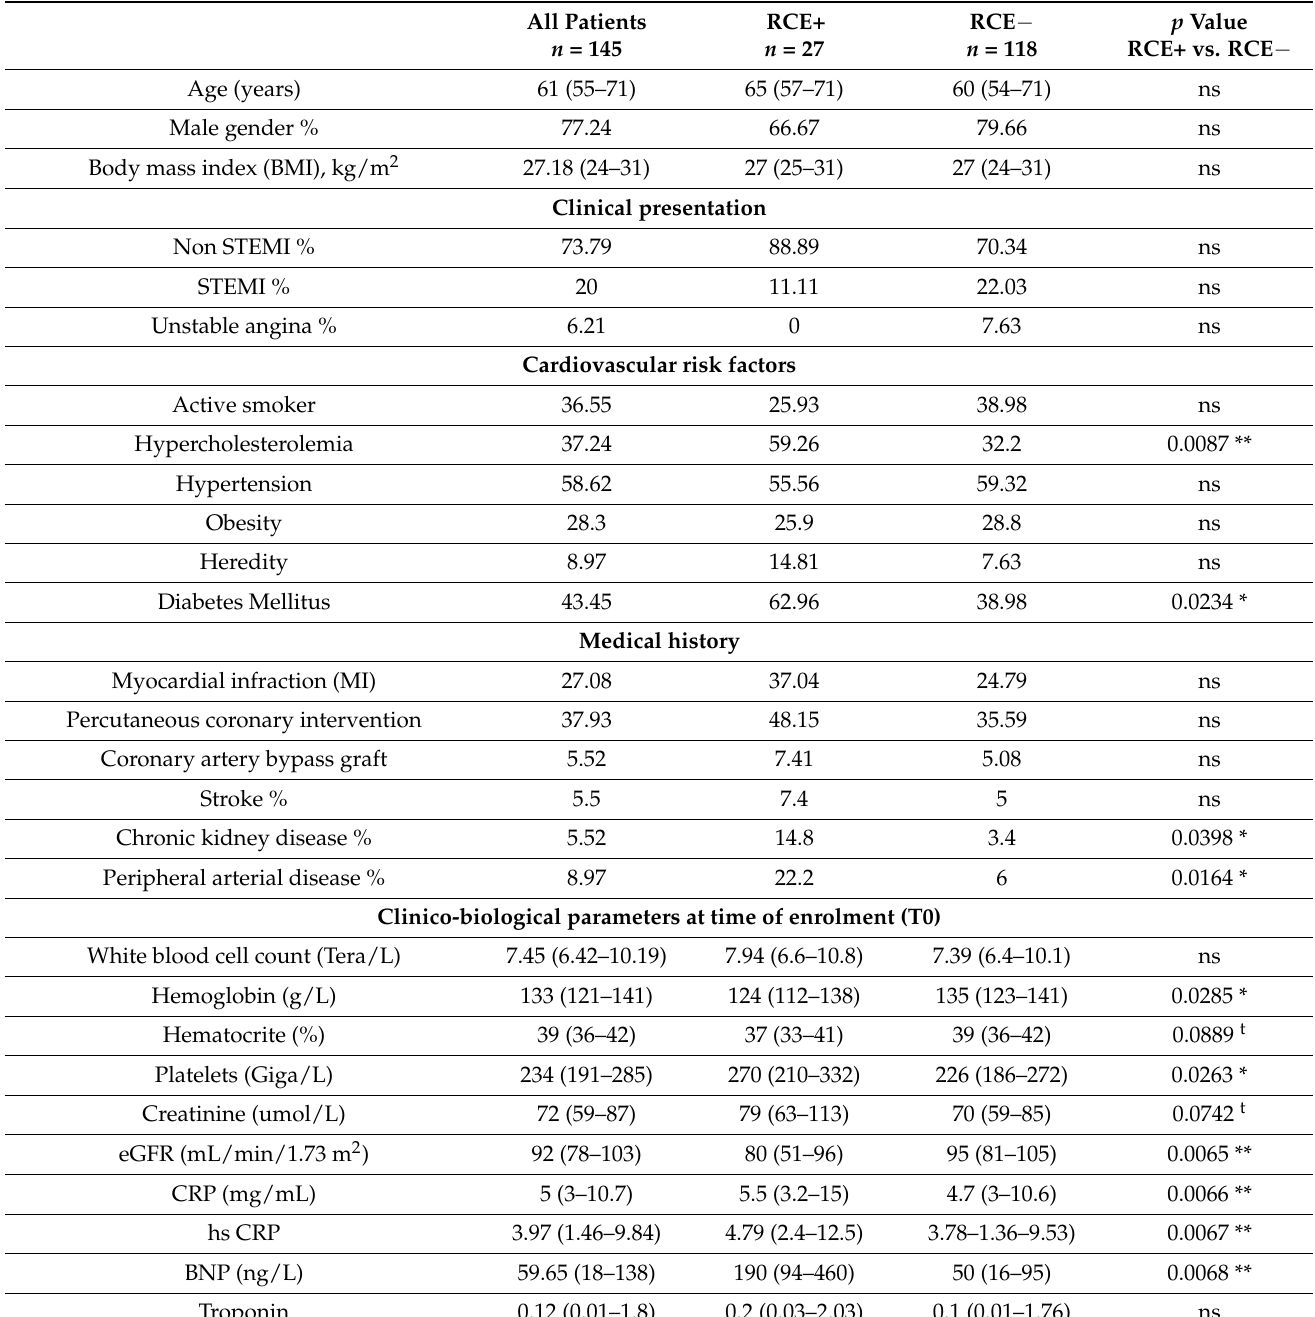
Table 2. Patients’